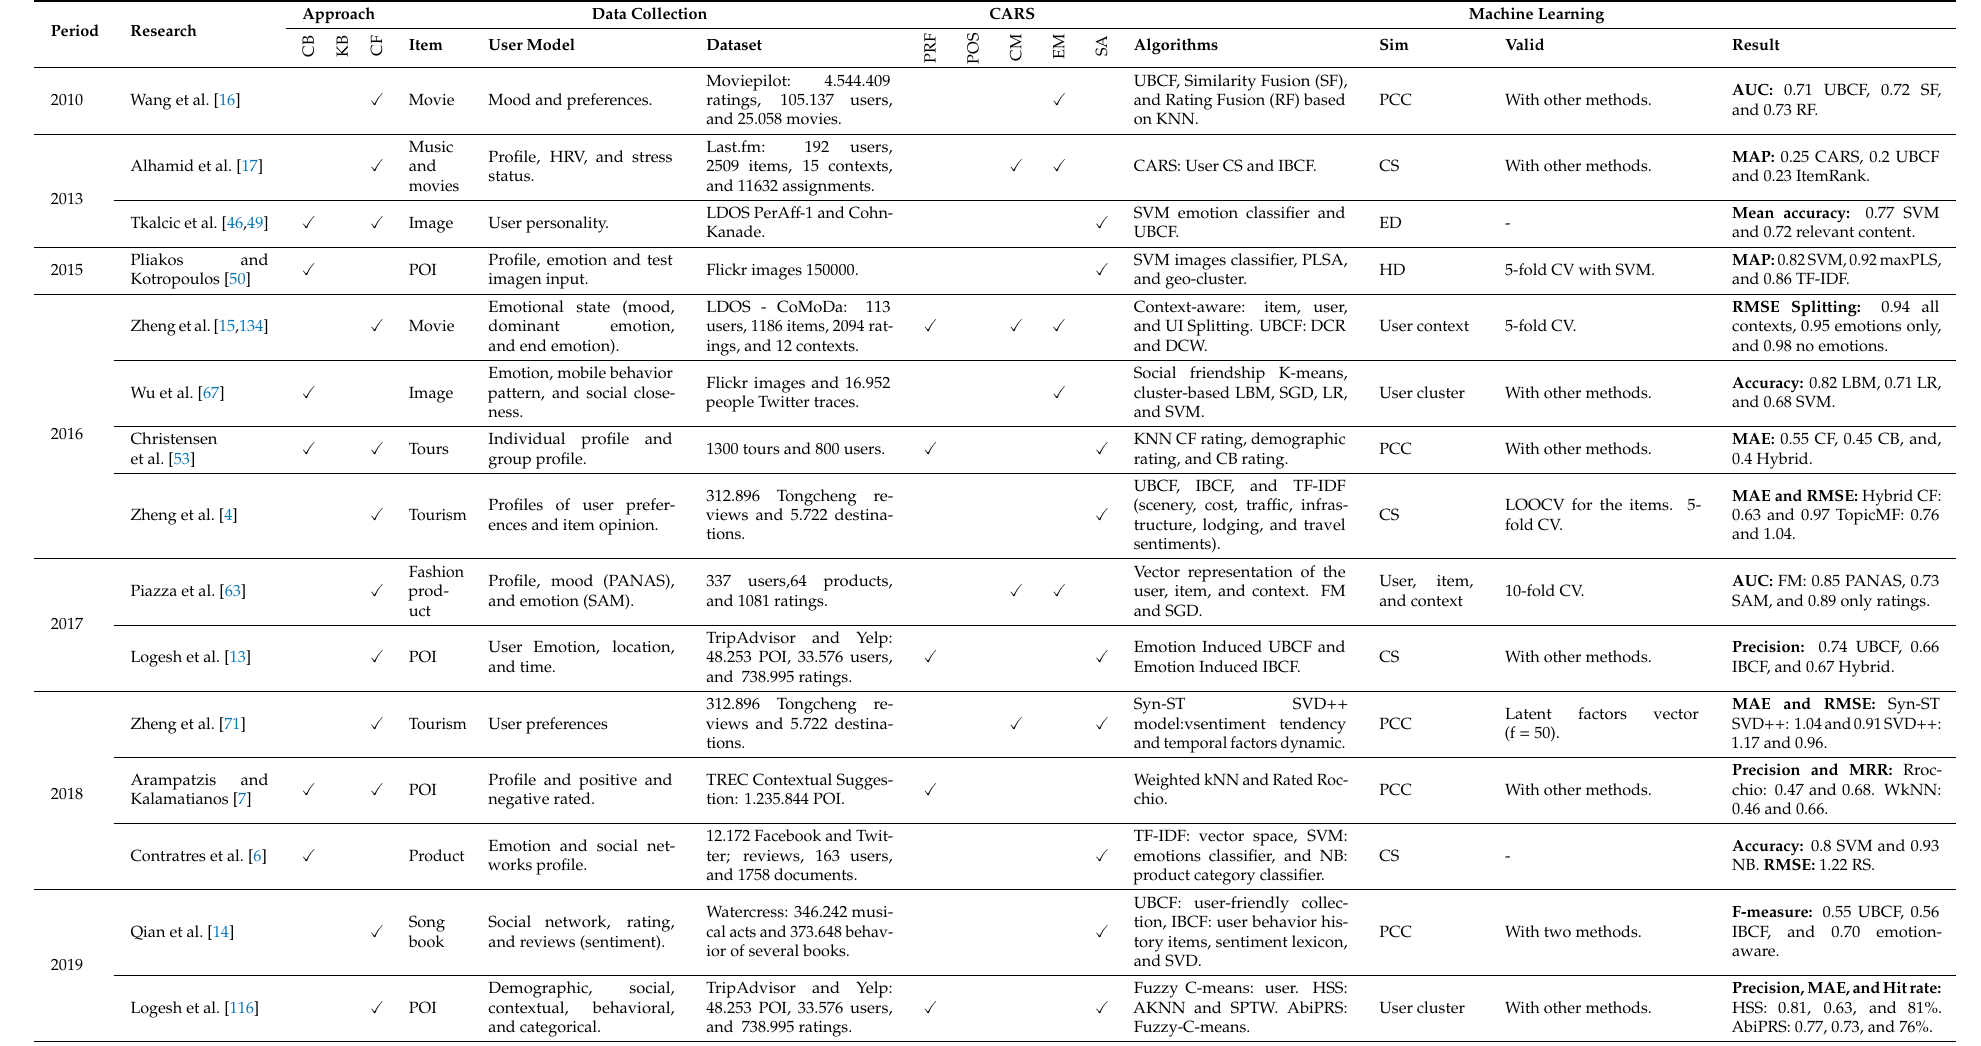
Table 3. Implementation of recommendation systems based on emotions in various contexts